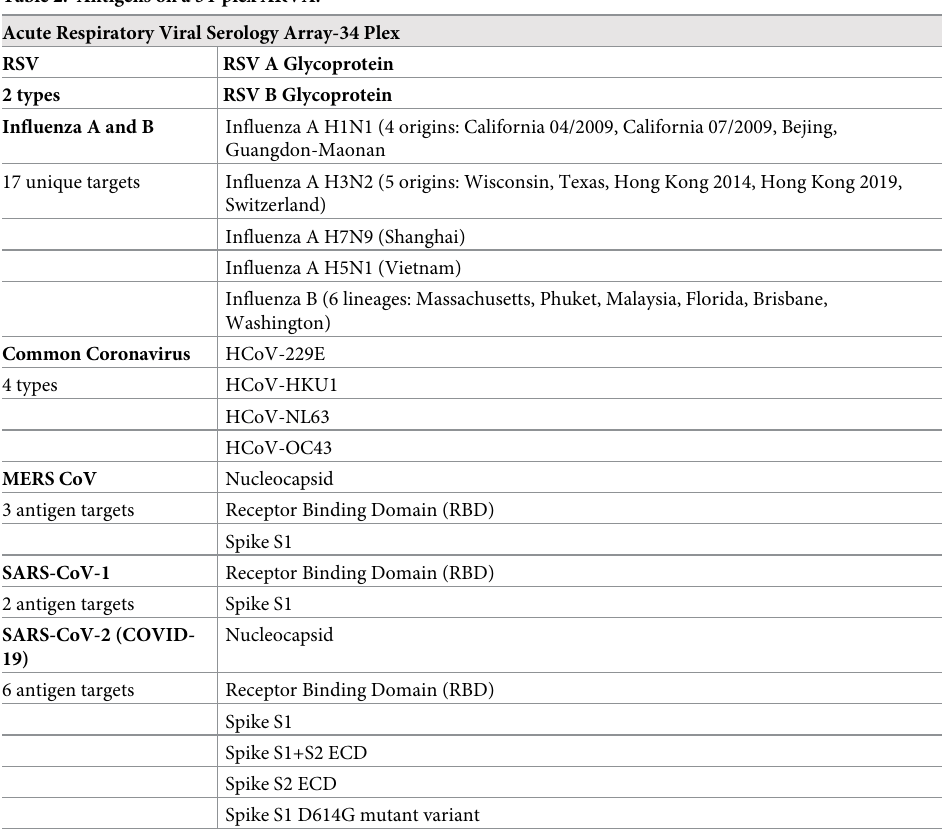
Table 2. Antigens on a 34-plex ARVA.